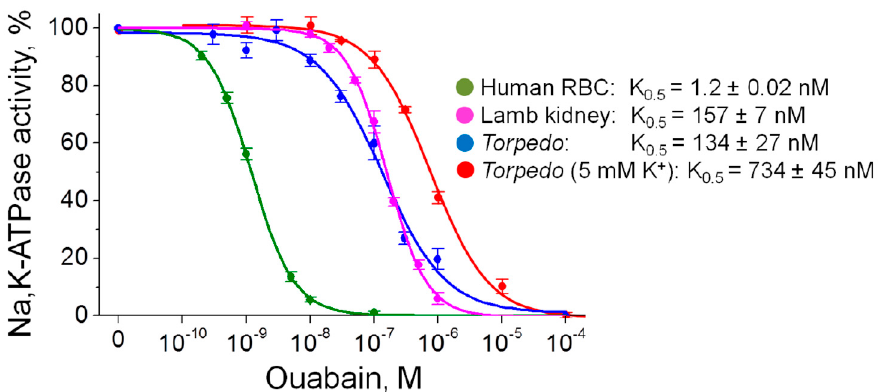
Figure 4. Inhibitory effects of ouabain on Na,K-ATPase activity in human red blood cells (RBC), purified lamb kidney and Torpedo membrane preparations. Incubation was performed with various concentrations of ouabain for 3 h in K + free solutions; Torpedo membrane preparations were also incubated in the presence of 5 mM K + . The solid lines are a fit to the Hill equation; the corresponding calculated inhibitory constants K 0.5 are indicated.